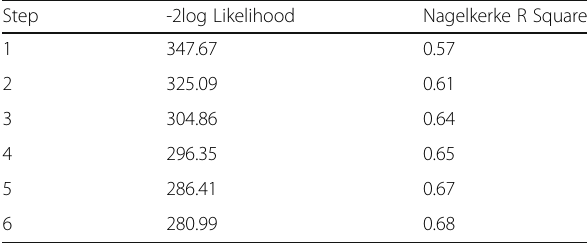
Table 3 Model Summary for Six Steps of LR Model